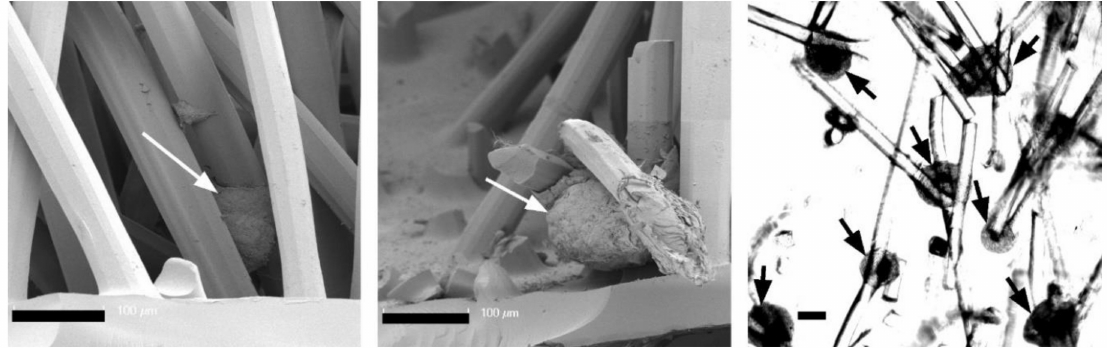
Figure 5. Formation of spheroids, 21 days after colonization with human chondrocytes in pure chitosan flock scaffolds (CFS) under chondrogenic cultivation conditions. Left/center: SEM micrographs of cross-sections, right: light-microscopic image. The formed cell aggregates are marked by arrows. Scale bars: 100 µ